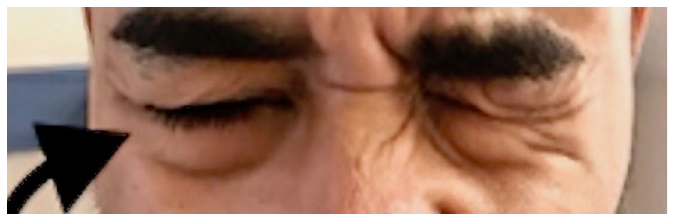
Image 3. Inability to contract right orbicularis oculi